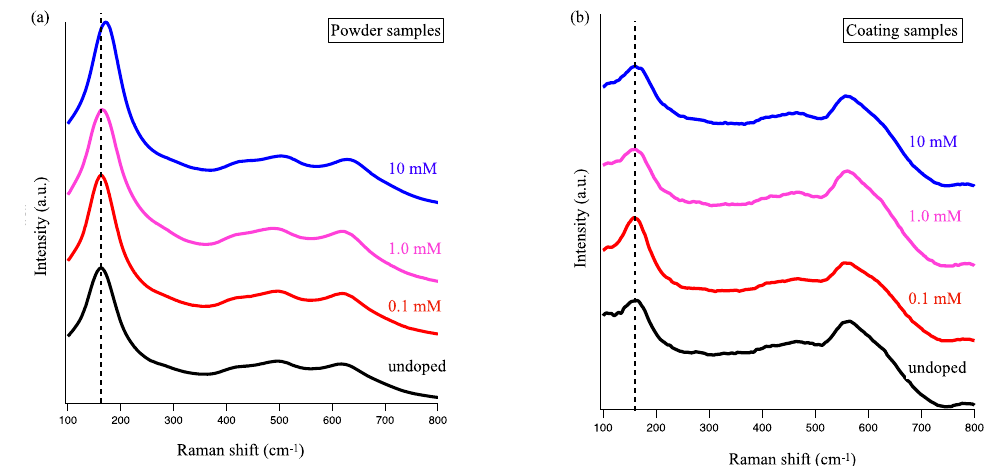
Figure 7. Raman spectra of Cu-TiO 2 ( a ) powder and ( b ) coating samples. Black line indicates undoped TiO 2 . Red, pink, and blue lines correspond to Cu concentrations of 0.1, 1.0, and 10 mM, respectively.